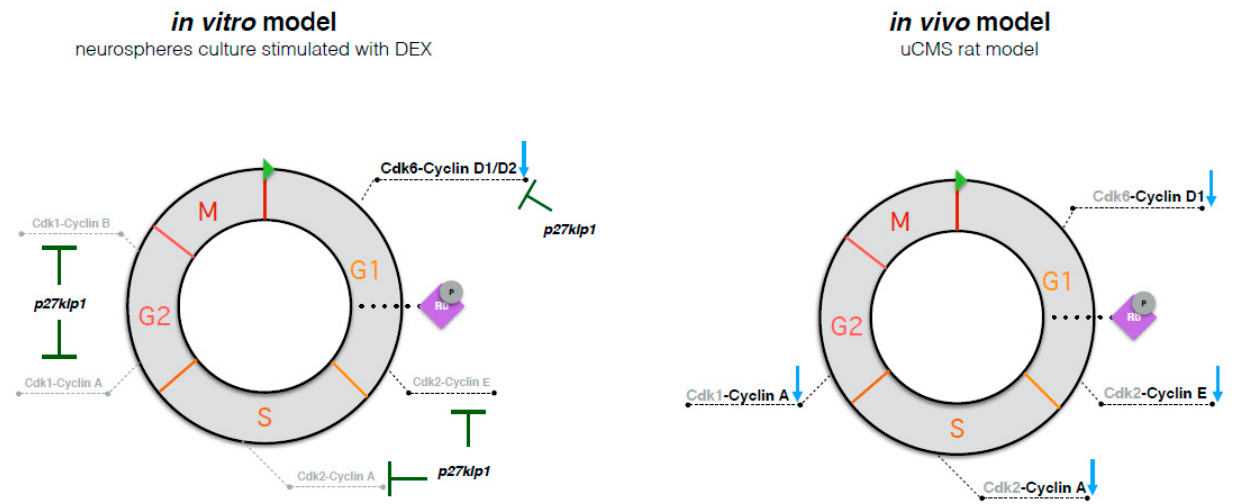
Figure 3. Schematic representation of the effects observed in cell cycle-regulatory molecules in both in vitro and in vivo experimental models used in this study.